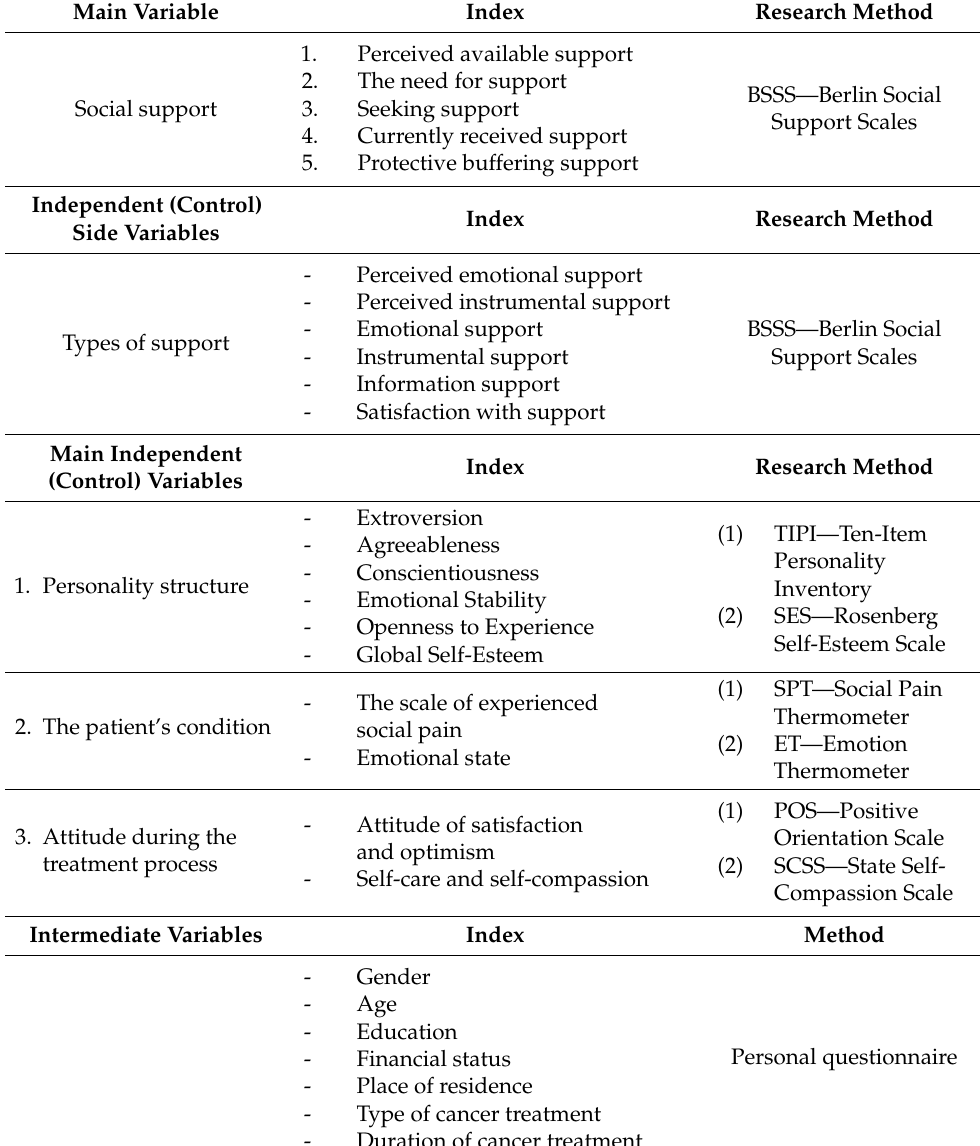
Table 1. Investigated variables and applied research